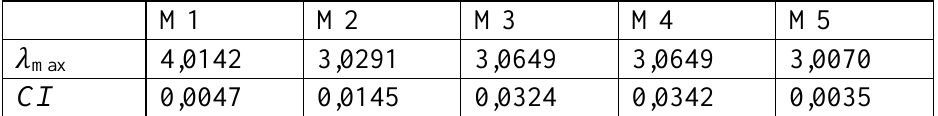
Table 4.7 CI Values for each matrix.